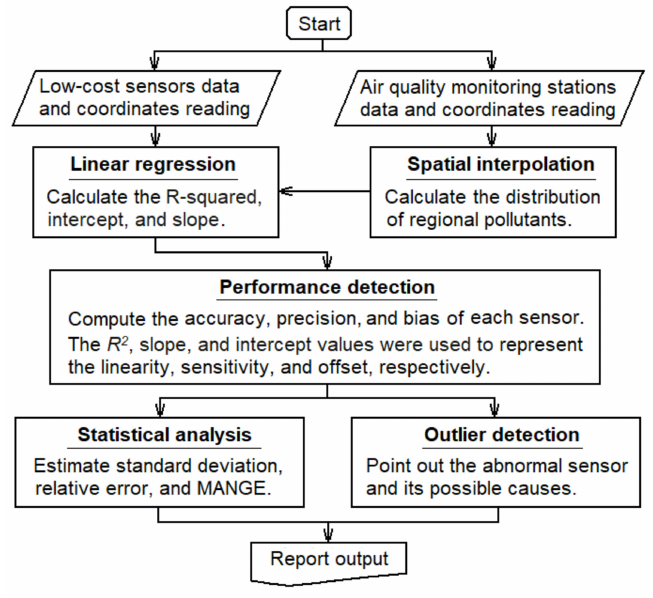
Figure 2. The suggested flowchart of performance